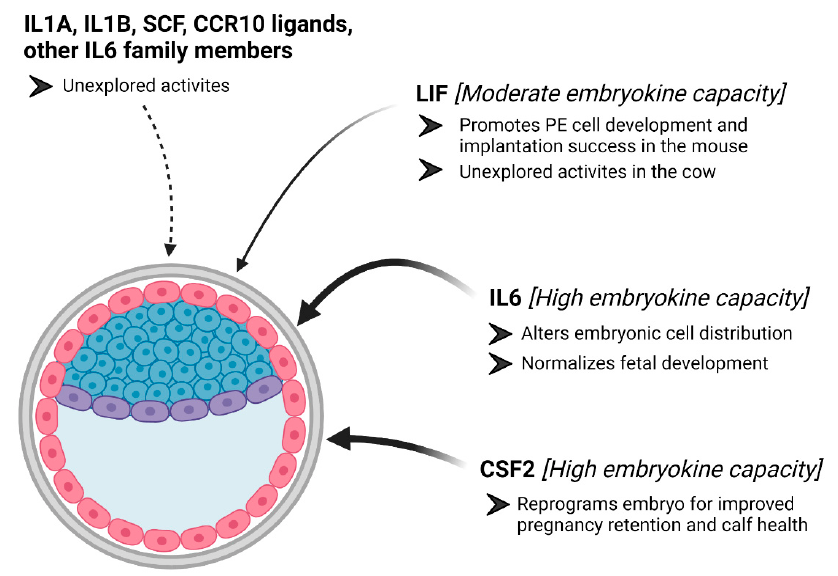
Figure 2. Model of our current knowledge about embryokine actions for cytokines. Colony-stimulating factor 2 (CSF2) and interleukin 6 (IL6) contain embryokine activity in bovine embryos (an illustration of a bovine embryo is provided). Leukemia inhibitory factor (LIF) may contain embryokine activity, but this activity is suggested namely because of embryokine actions for LIF in the mouse embryo. Several other potential cytokines may serve as embryokines, but work is needed to describe these potential activities. The figure was created with BioRender.com.